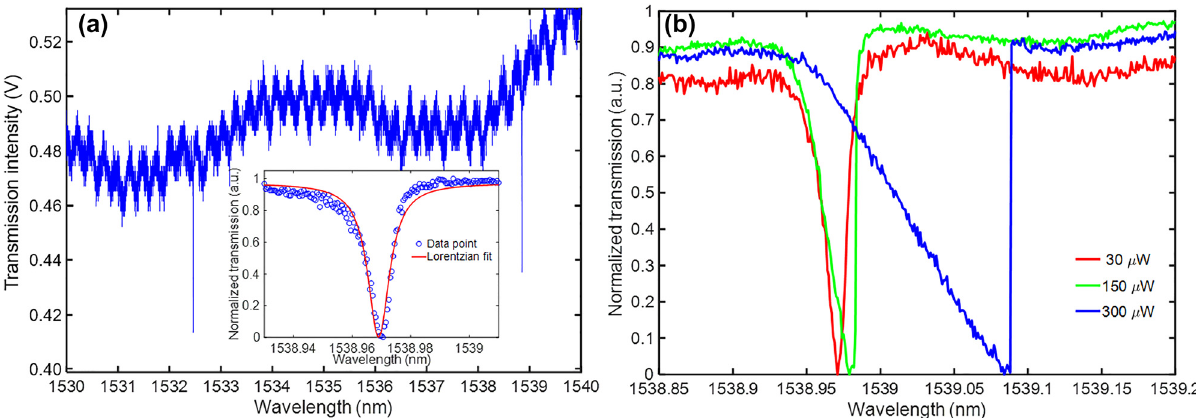
Figure 4: Optical transmission spectrum of the optomechanical zipper cavity. (a) The fundamental TE 1,o and TE 1,e modes of the zipper cavity. Inset shows the resonance of TE 1,e mode with Lorentzian fi tting to obtain an optical Q -factor up to 1 . 5 × 10 5 . (b) Resonance broadening of TE 1,e modes with the increasing pump